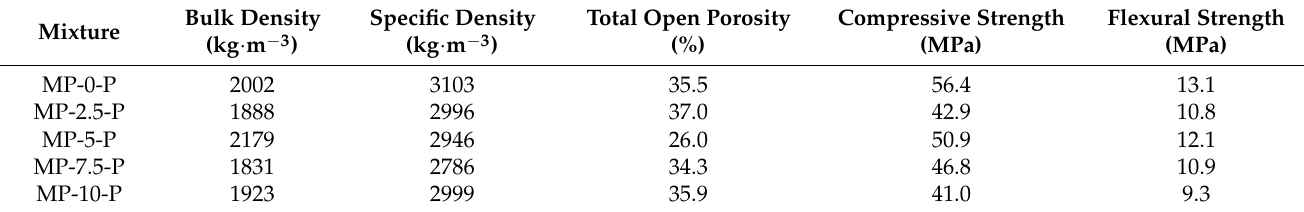
Table 7. Basic structural characteristics of the hardened